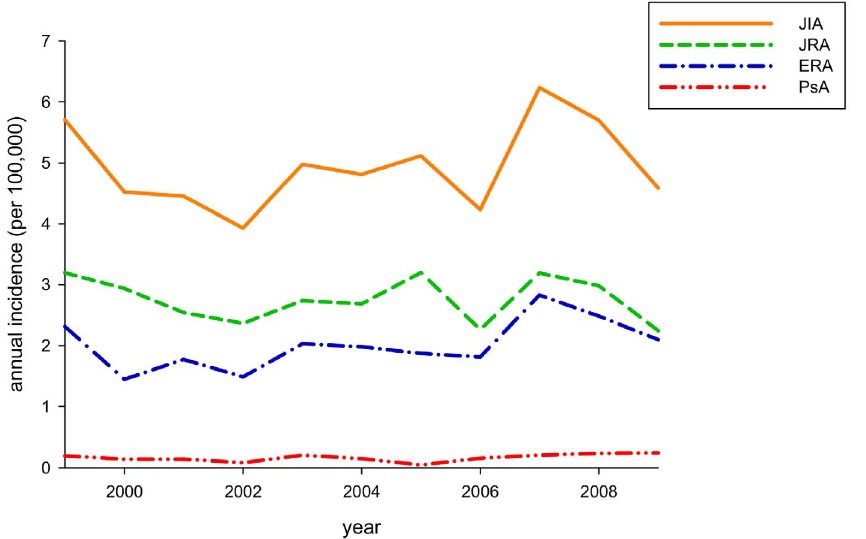
Figure 1. Annual incidence of juvenile idiopathic arthritis (JIA), juvenile rheumatoid arthritis (JRA), enthesitis-related arthritis (ERA), and psoriatic arthritis (PsA) for the period 1999 – 2009.